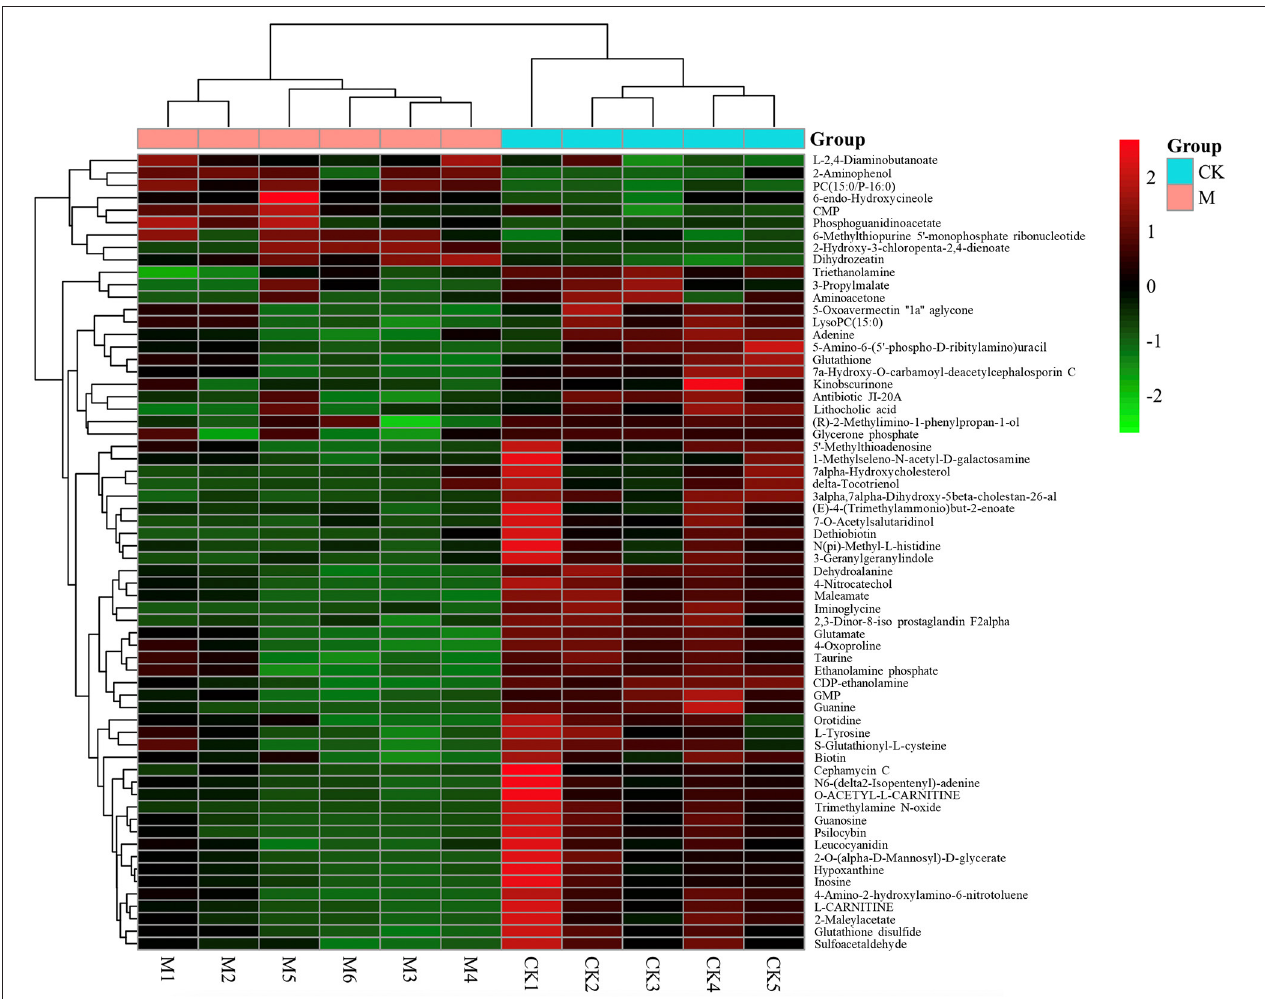
FIGURE 5 | Heat-map of differential metabolites identified between model and control group by KEGG pathways. n = 5–6 mice per group. Rows: differential metabolites; columns: samples. The color of each small square represents the level of metabolite expression. Red: highest; green: lowest; black;